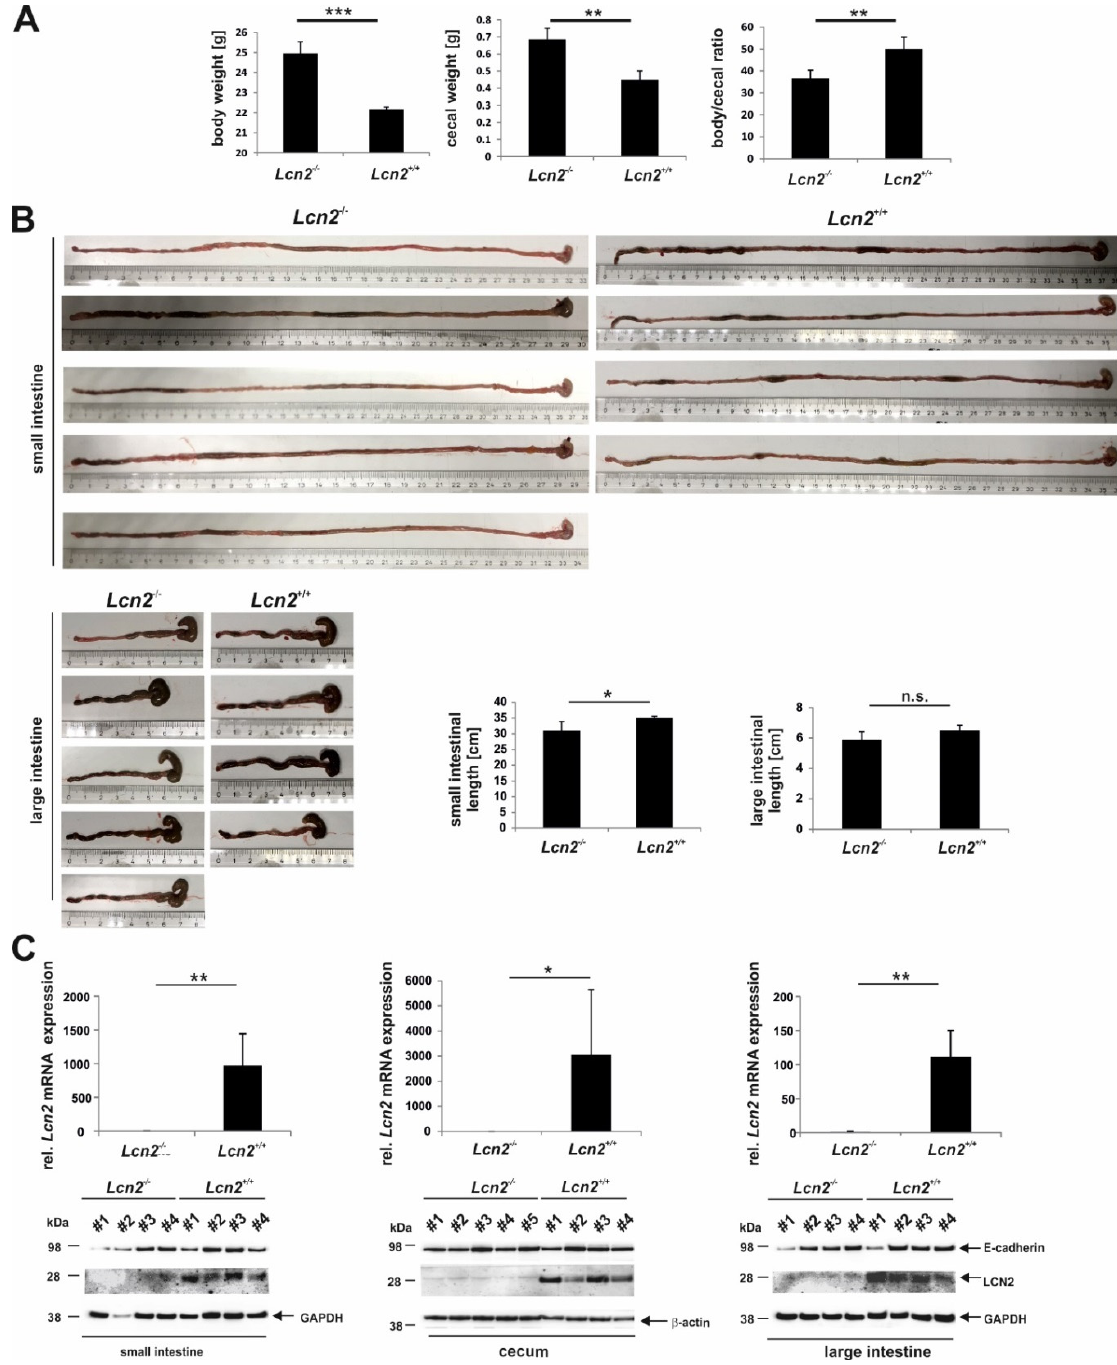
Figure 8. Comparative analysis of the intestine macroscopical parameters and expression of Lcn2 in wild type (n = 4) and Lcn2 -/- mice (n = 4 or 5). ( A ) Evaluation of the body weight of male animals at the same age (left). Corresponding ceca were prepared and weighed (middle). Ratio of body to cecal weight (right). ( B ) Gross macroscopical and graphical comparison of the total small and large intestinal lengths measured (n = 4 or 5). ( C ) Quantitative analysis of Lcn2 mRNA (upper) and LCN2 protein expression (lower) in the distal small intestine (left) cecum (middle), and distal colon (right) of wild type ( Lcn2 +/+ ) and Lcn2 null mice (each n = 4 or 5). Relative mRNA expression of respective genes was done by RT-qPCR and normalized to Gapdh or β -actin . Equal protein loading was demonstrated by re-probing the membranes with a specific antibody directed against GAPDH or β -actin. E-cadherin was probed as a marker for epithelial-to-mesenchymal transition (EMT). Primers used are given in Supplementary Table S1. Statistical evaluation in (A–C) was performed by an unpaired t -test, whereby the difference of two samples from a level of p < 0.05 is considered statistically significant (*: p < 0.05, **: p < 0.01, ***: p < 0.001).